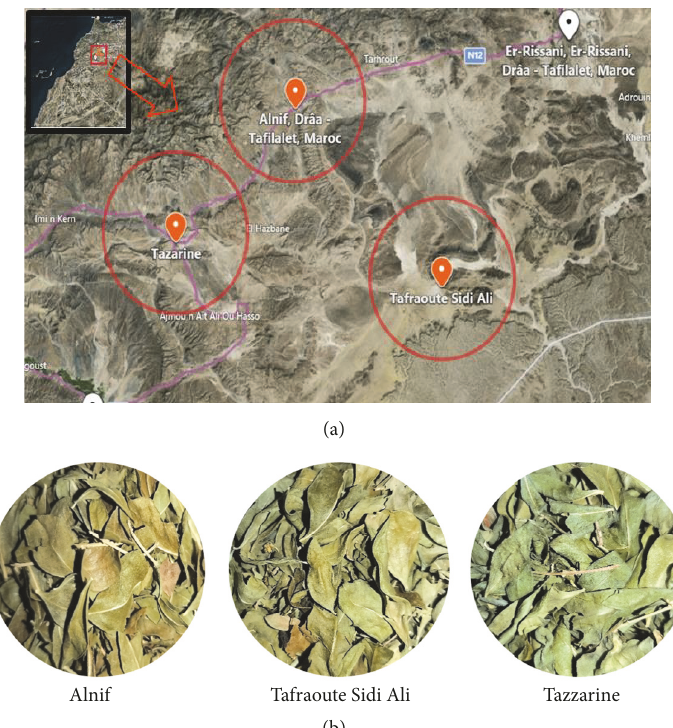
Figure 1: (a)Map situation of the three MoroccanHenna varieties sites used as primary materiel[14]; (b) photographic images of the different